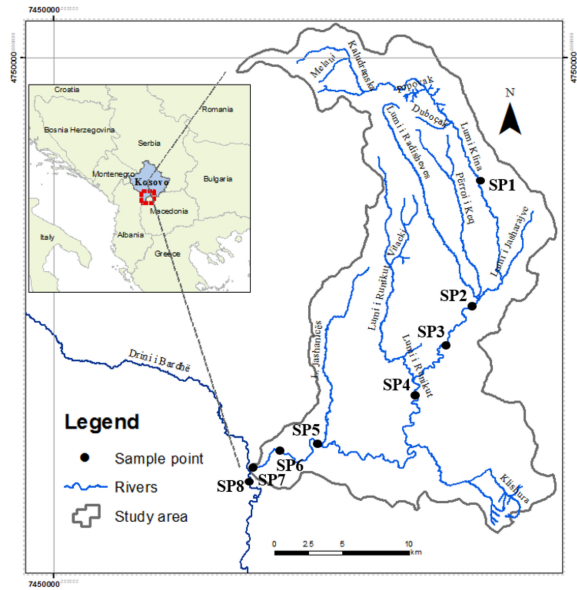
Figure 1. Location of investigated